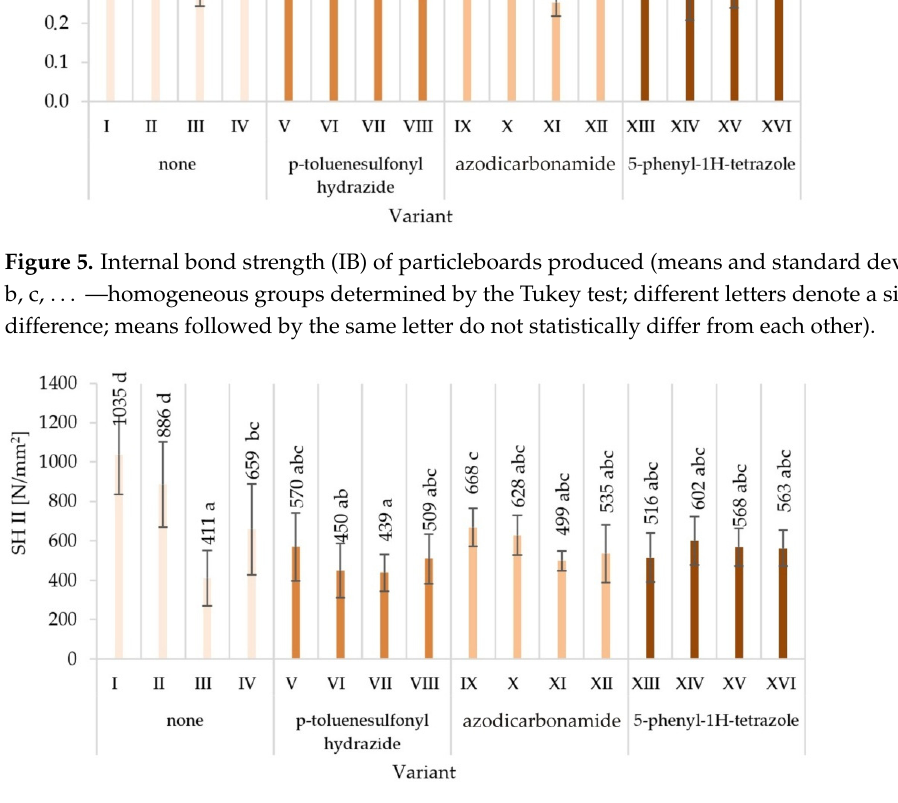
Figure 7. Screw holding perpendicular to the surface (SH Ʇ ) of particleboards produced (means and standard deviation, a, b, c, …—homogeneous groups determined by the Tukey test; different letters denote a significant difference; means followed by the same letter do not statistically differ from each other).